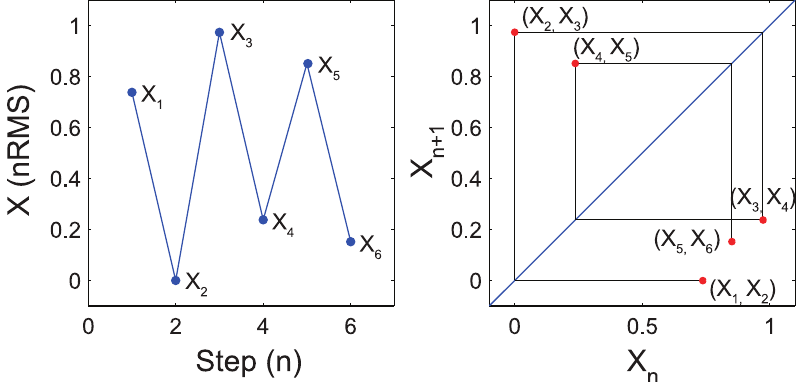
Fig 1. Return map analysis. Return map of the time series of the observeddata (right panel), X n versus X n + 1 using the amplitudeof nRMS at each step corresponding to the series of points (blue circles) in the left panel.